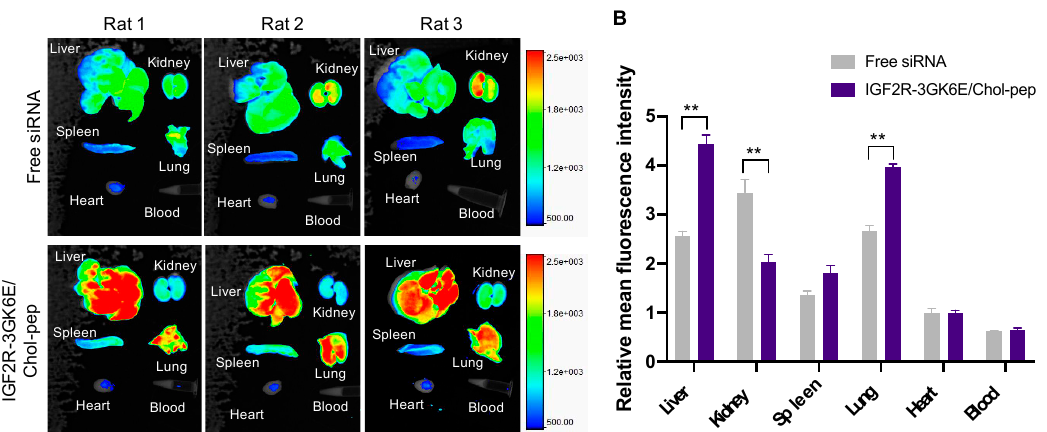
Figure 7. Biodistribution of the nanocomplexes in rats with CCl 4 -induced liver fibrosis. The rats were injected with free Cy5-labeled siRNA and IGF2R-3GK6E-modified Cy5-labeled siRNA nanocomplex at 1 mg/kg siRNA via tail vein, respectively. The rats were euthanized for 2 h post-injection, and the organs including the liver, kidneys, spleen, lungs, heart, and blood were harvested for fluorescence analysis. ( A ) Fluorescence images of the major organs. The region of interest (ROI) for each organ was determined by the Bruker molecular imaging software. ( B ) Relative mean fluorescence intensities of the major organs. Results are presented as the mean ± SEM ( n = 3). (** p <